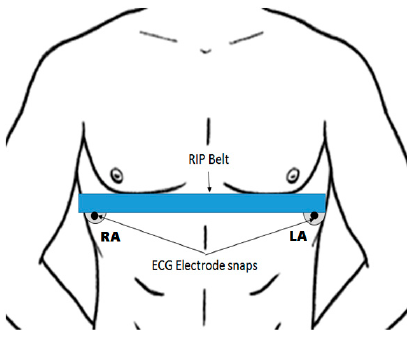
Figure 7. Electrode placement for the acquisition of respiration and heart activity (right arm: RA; left arm: LA).